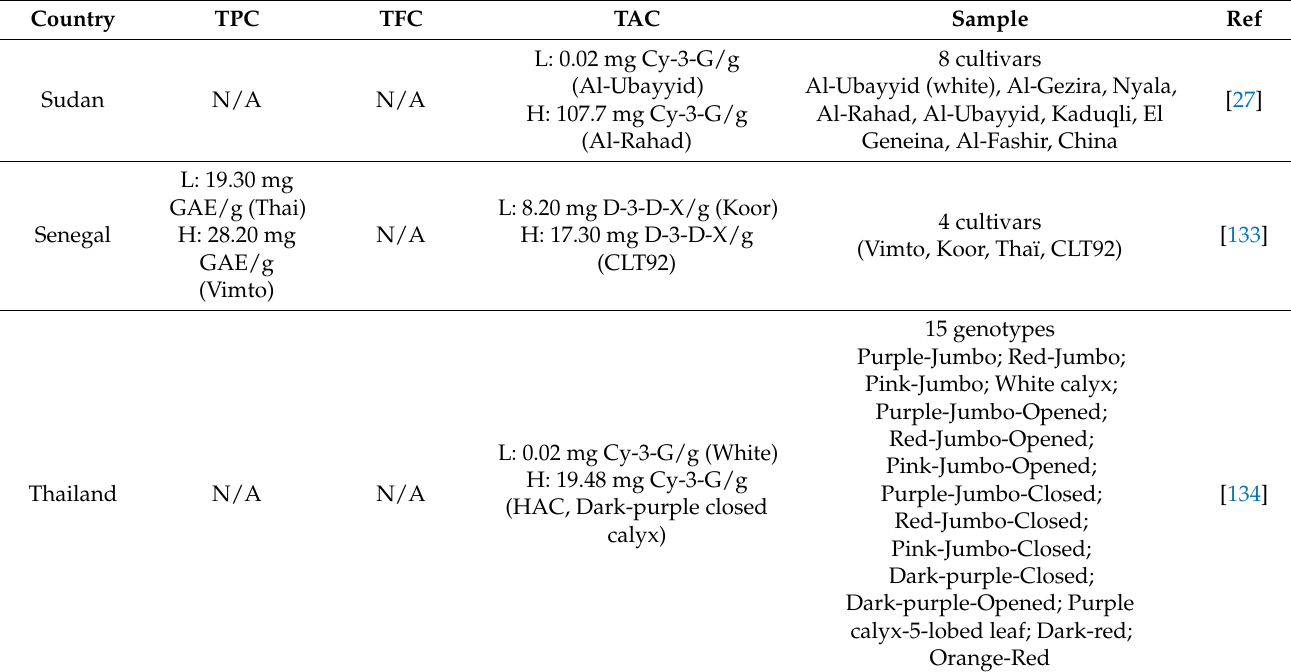
Table 3. Total concentration of phenolic compounds from roselle. Abbreviations: N/A: not available, TPC: total phenolic compound, TFC: total flavonoid compound, TAC: total anthocyanin compound, L: lowest value detected, and H: highest value